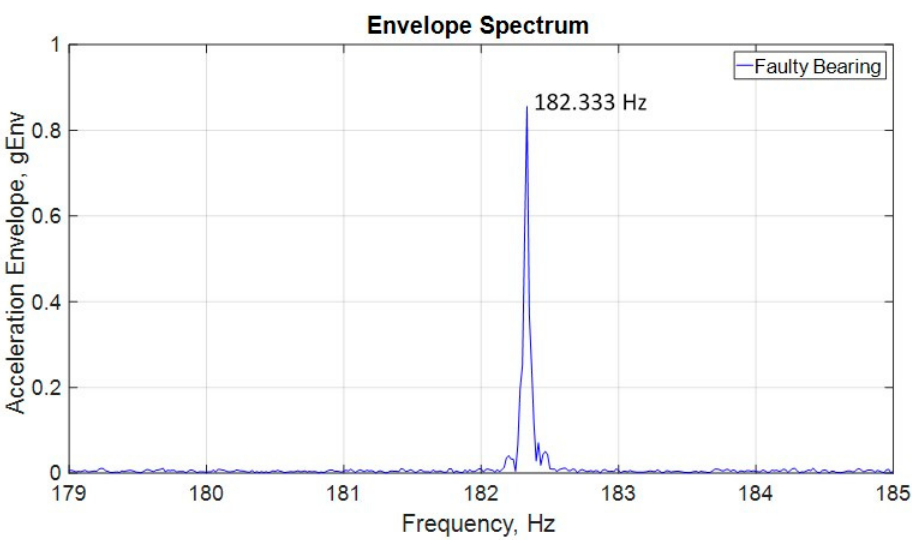
Figure 14. Acceleration envelope spectrum with zoom in the actual BPFO x f r .